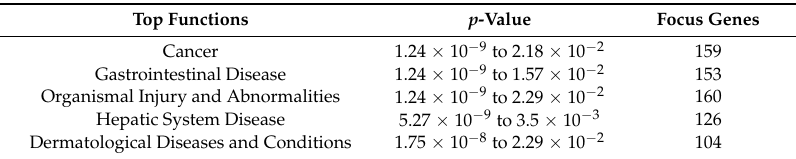
Table 2. Biological functions associated with